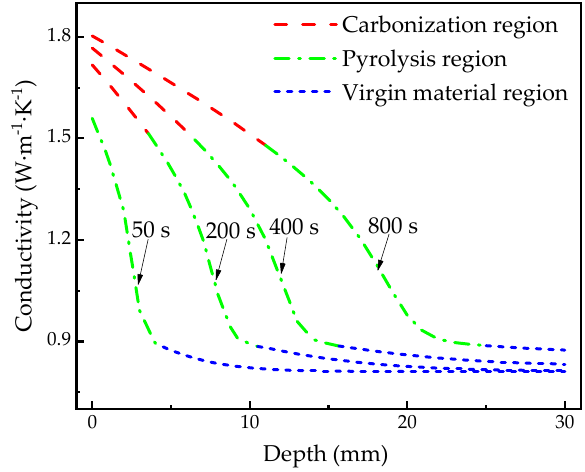
Figure 12. Thermal conductivity with depths at 50, 200, 400, 800 s.